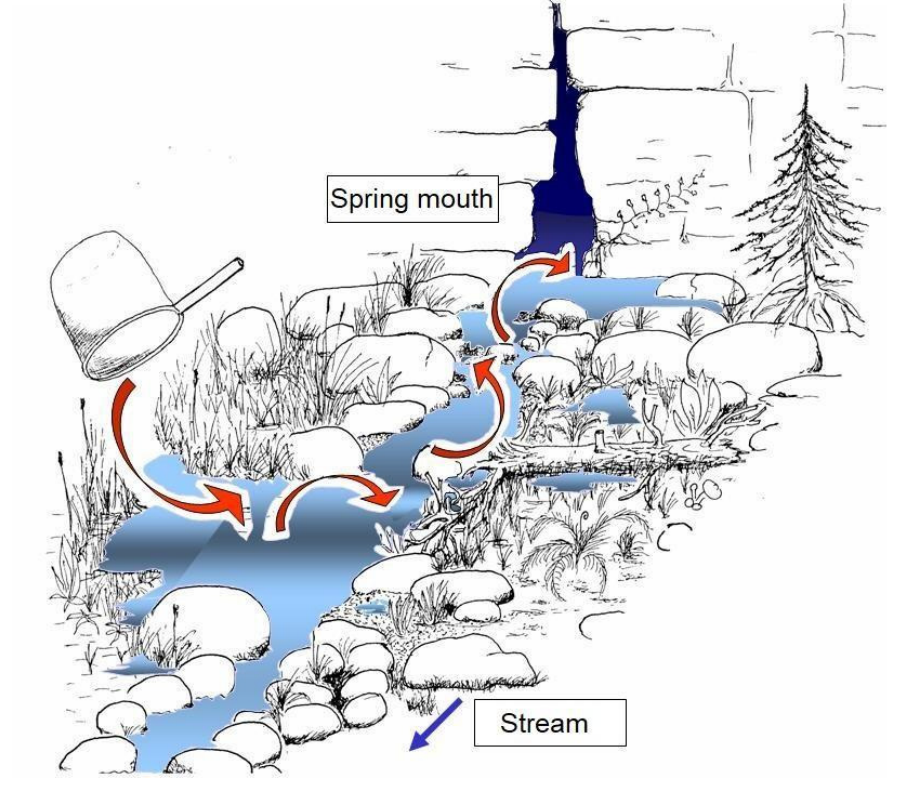
Figure 8. Integrative zoobenthos sampling in spring habitats.